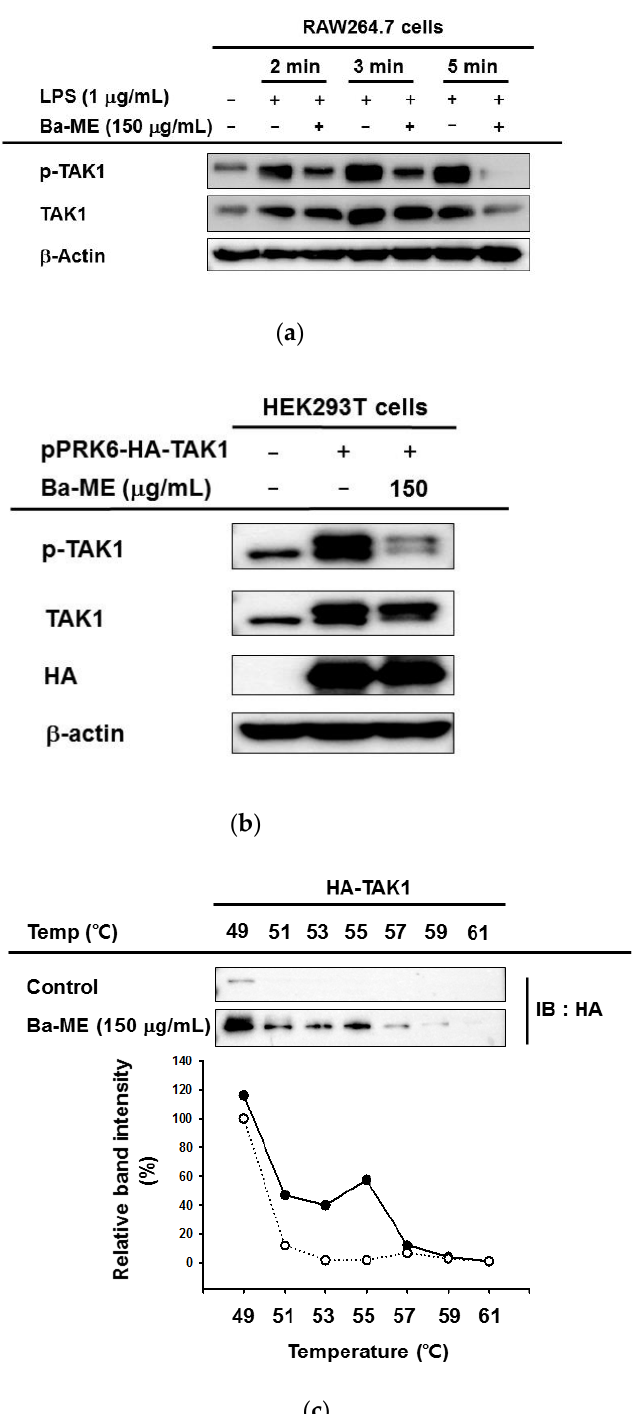
Figure 4. ( a ) RAW264.7 cells were incubated with Ba-ME in the absence or presence of LPS (1 µg/mL) for the designated times. After whole-cell lysates, employing immunoblotting to identify levels of total and phosphoforms of upstream TAK1 signaling enzymes. ( b ) After 24 h transfected pPRK6-HA-TAK1 constructs with HEK293T cells, treatmentt with Ba-ME was advisable, using a Western blot analysis to determine the levels of phosphorylated and total forms of TAK1-HA. ( c ) After overexpressing TAK1 in HEK293T cells, a CETSA was performed with Ba-ME (150 µg/mL), and dimethyl sulfoxide was used as a control. A Western blot analysis was conducted to examine the stabilization of Ba-ME on TAK1. Solid circles are Ba-ME group and hollow circles are control group.